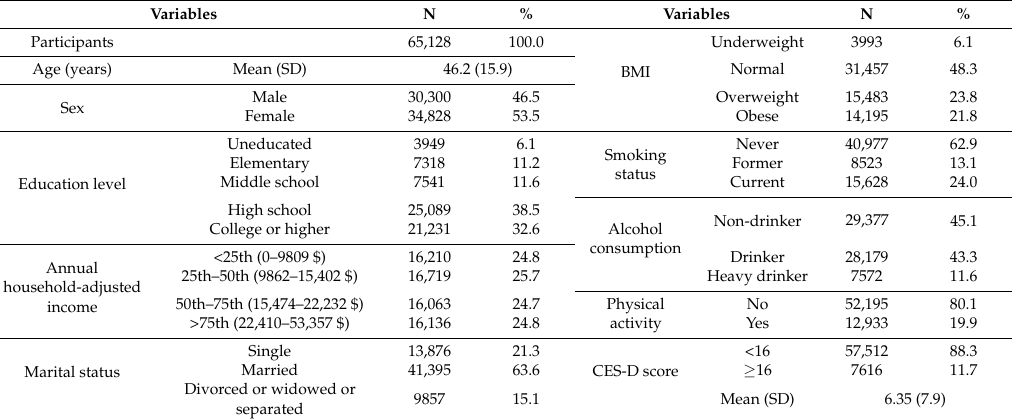
Table 1. Characteristics of the study population.